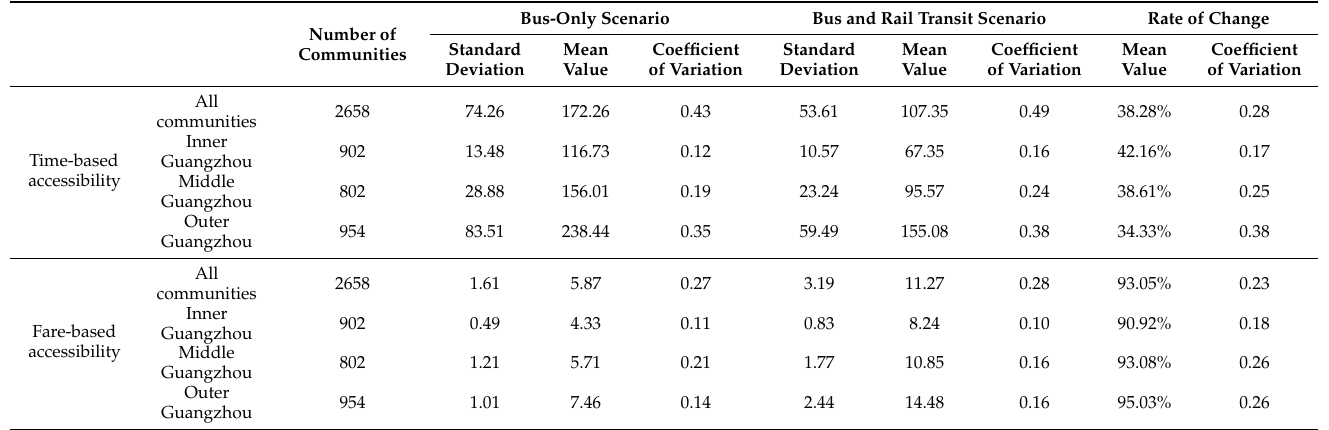
Table 3. Coefficient of variation ( CV ) of time-based accessibility and fare-based accessibility. Bus-Only Scenario Bus and Rail Transit Scenario Rate of Change Number of Standard Mean Coefficient Standard Mean Coefficient Mean Coefficient Communities Deviation Value of Variation Deviation Value of Variation Value of